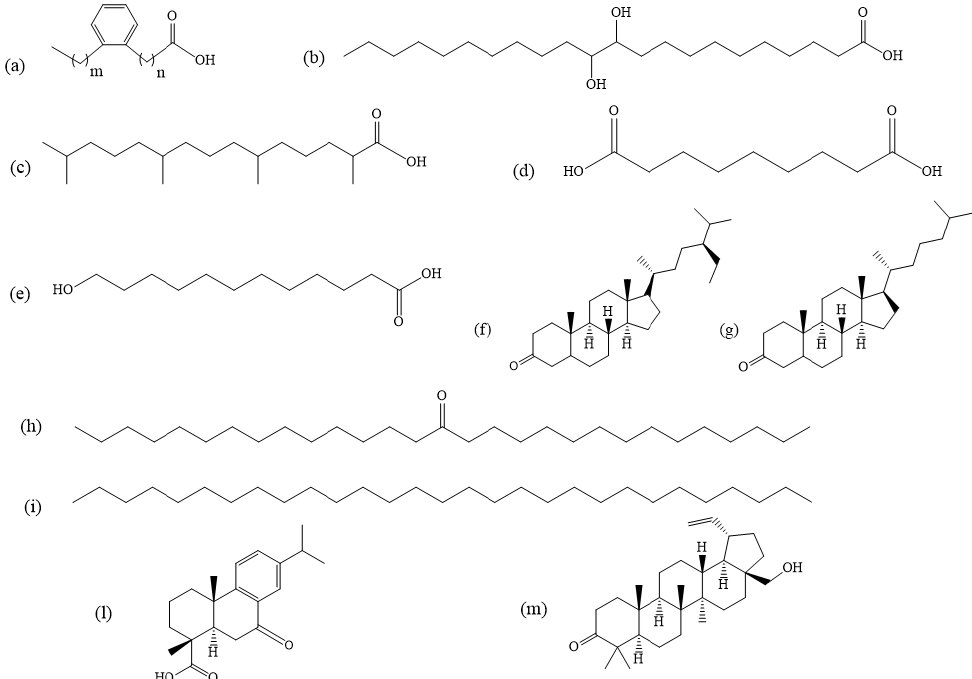
Figure 2. Examples of lipids degradation products detected in archaeological pottery samples: ( a ) ω -(o-alkylphenyl)alkanoic acid, ( b ) 11,12-dihydroxydocosanoic acid, ( c ) pristanic acid, ( d ) azelaic acid, ( e ) ω -hydroxydodecanoic acid, ( f ) sitostanone, ( g ) cholestanone, ( h ) nonacosan-15-one, ( i ) n -nonacosane, ( l ) 7-oxodehydroabietic acid, ( m ) betulone.